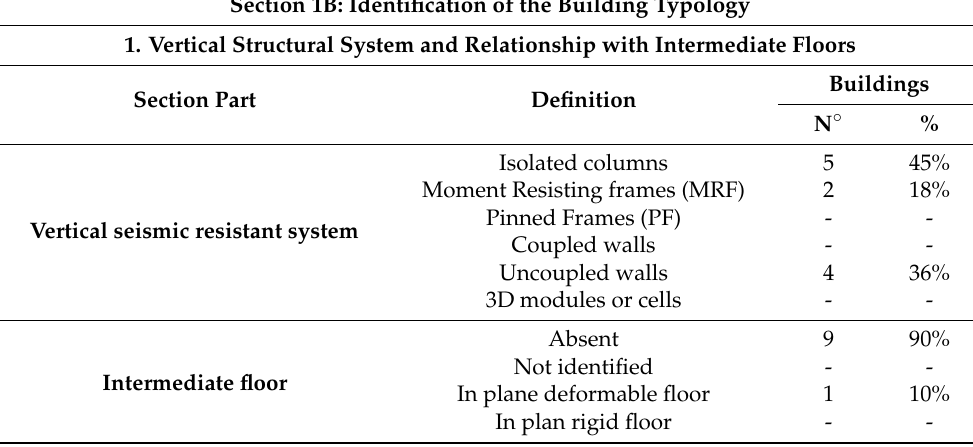
Table 5. Section 1B CARTIS-Building. Case studies characterization: 1. Vertical structural system and relationship with intermediate floors—Synoptic